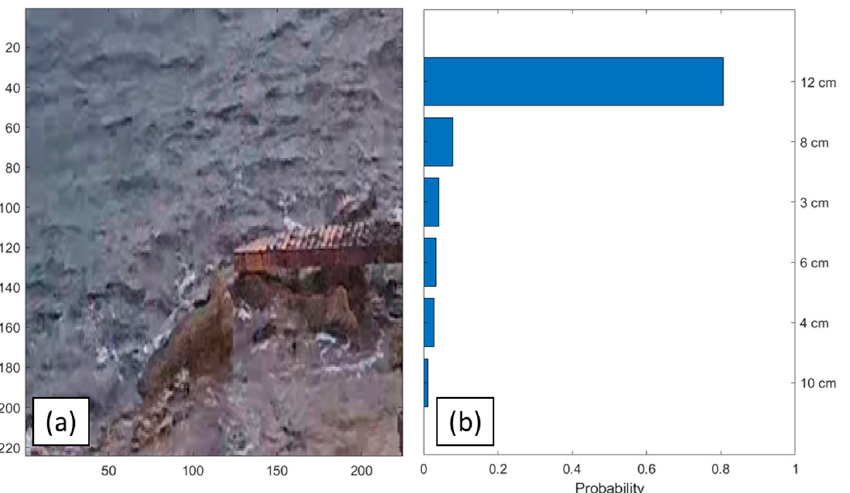
Figure 7. Probability of the tide classes obtained through CNN classification techniques applied on a webcam snapshot of Varco 11; ( a ) image of the time frame automatically extracted by webcam; ( b ) probability of the tide classes attributed to the time frame.